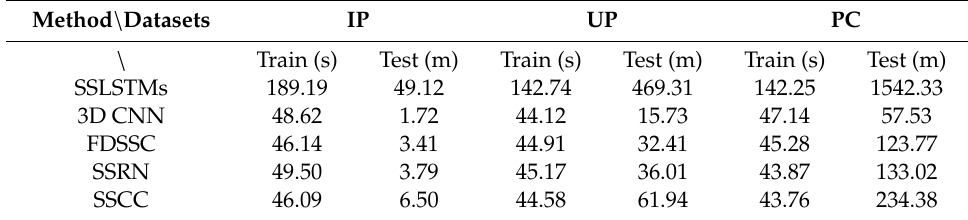
Table 6. The average testing times and training time for di ff erent methods on three HSI